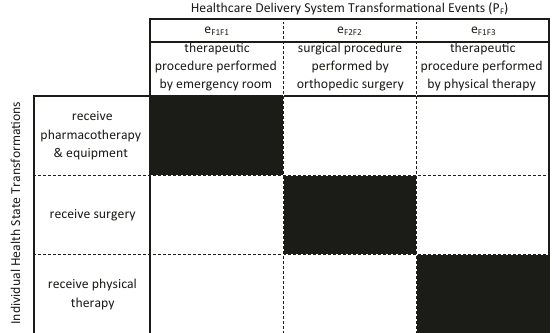
Figure 10: Individual Transformation Feasibility Matrix Λ 𝐹 for the acute orthopedic